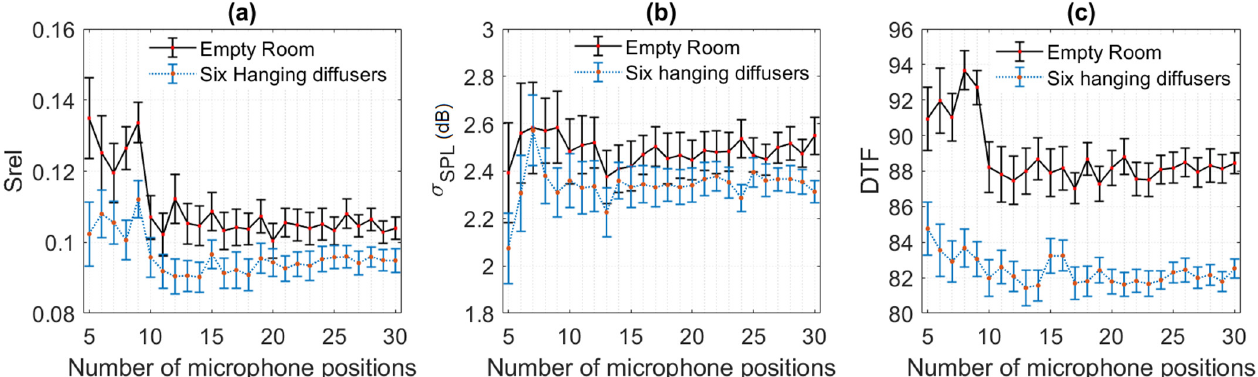
Figure 5. The diffuseness metrics of ( a ) s rel , ( b ) σ SPL and ( c ) DTF were measured in two diffuser configurations: (1) Empty room and (2) Room equipped with six hanging diffusers as a function of an increased number of microphone positions at 125 Hz. The error bar presents the 95% confidence interval of the metrics computed using 50 repetitions of a subset of combinations randomly selected among the full data set of 120 microphone positions.